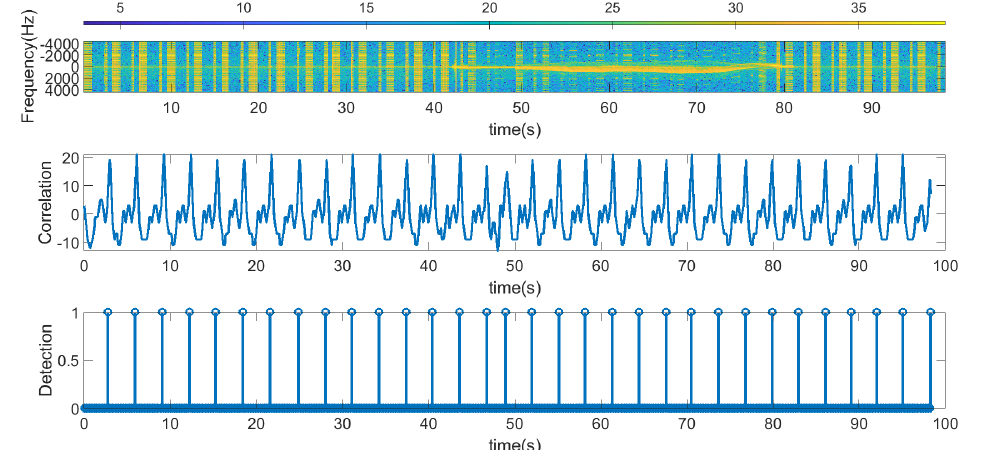
Figure 24. Data measurement using length 7 Barker codes when the scooter is in motion. From top to bottom: raw spectrogram before CFAR processor is applied, the output of the correlator signal and tag detection. The scooter is within the radar reading range at any time.